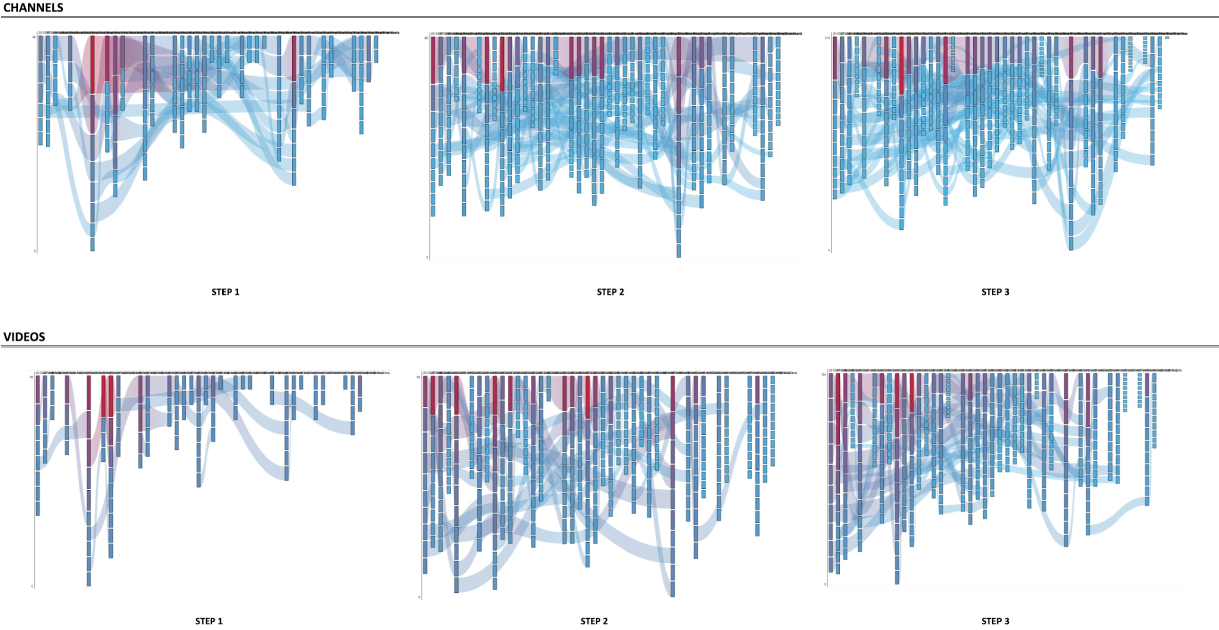
Figure 4. RankFlow visualization of “beauty” for the top 10 most recommended channels at step 1, step 2, and step 3 (top), and for the top 10 most recommended videos at step 1, step 2, and step 3 (bottom).